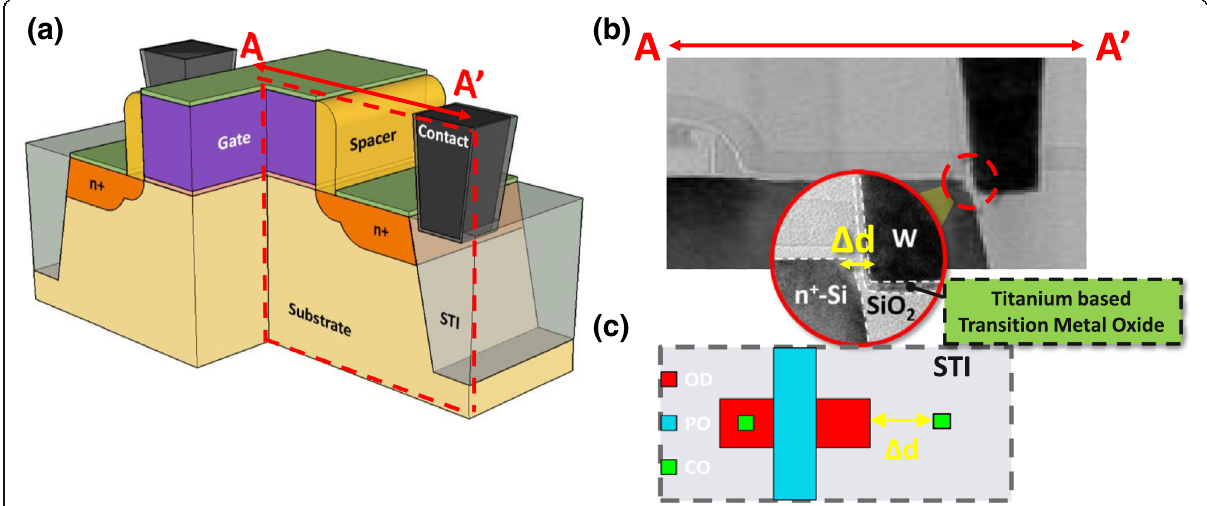
Fig. 1 a 3D illustration of a 1T1R cell with STI-ReRAM right next to the n+ junction. b The corresponding TEM picture of resistive storage node composed of transitional metal oxides, formed between a specially placed contact and the n+ region of the select transistor. c Layout